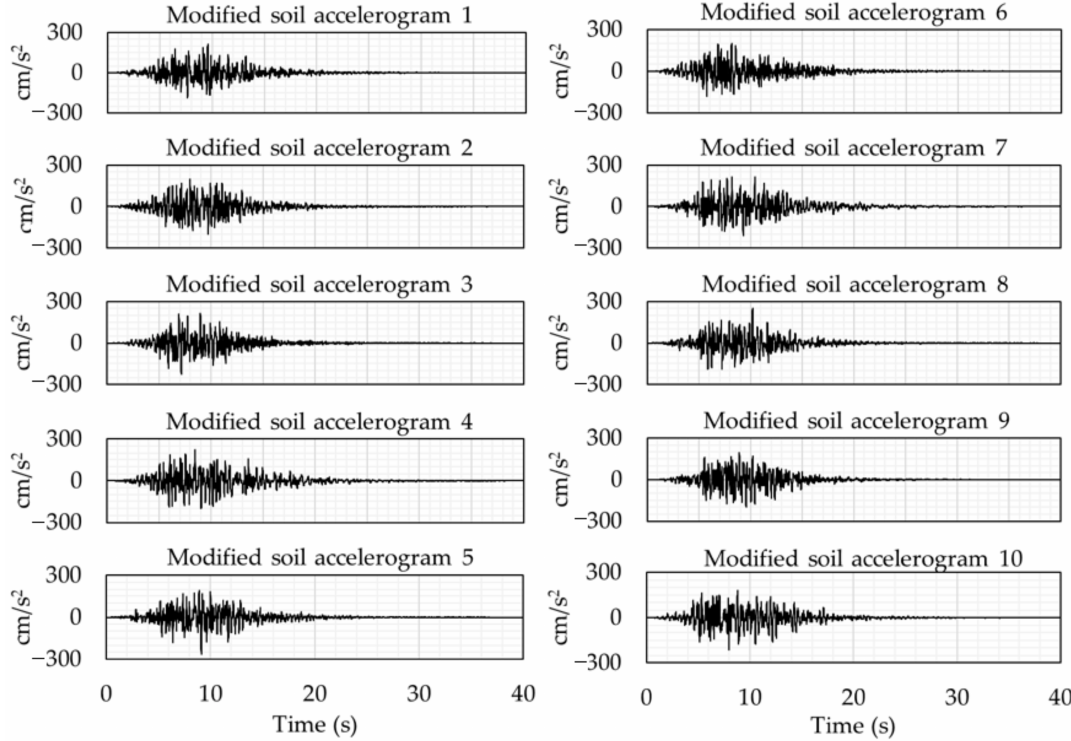
Figure 13. Synthetic accelerograms modified by the soil transfer function.